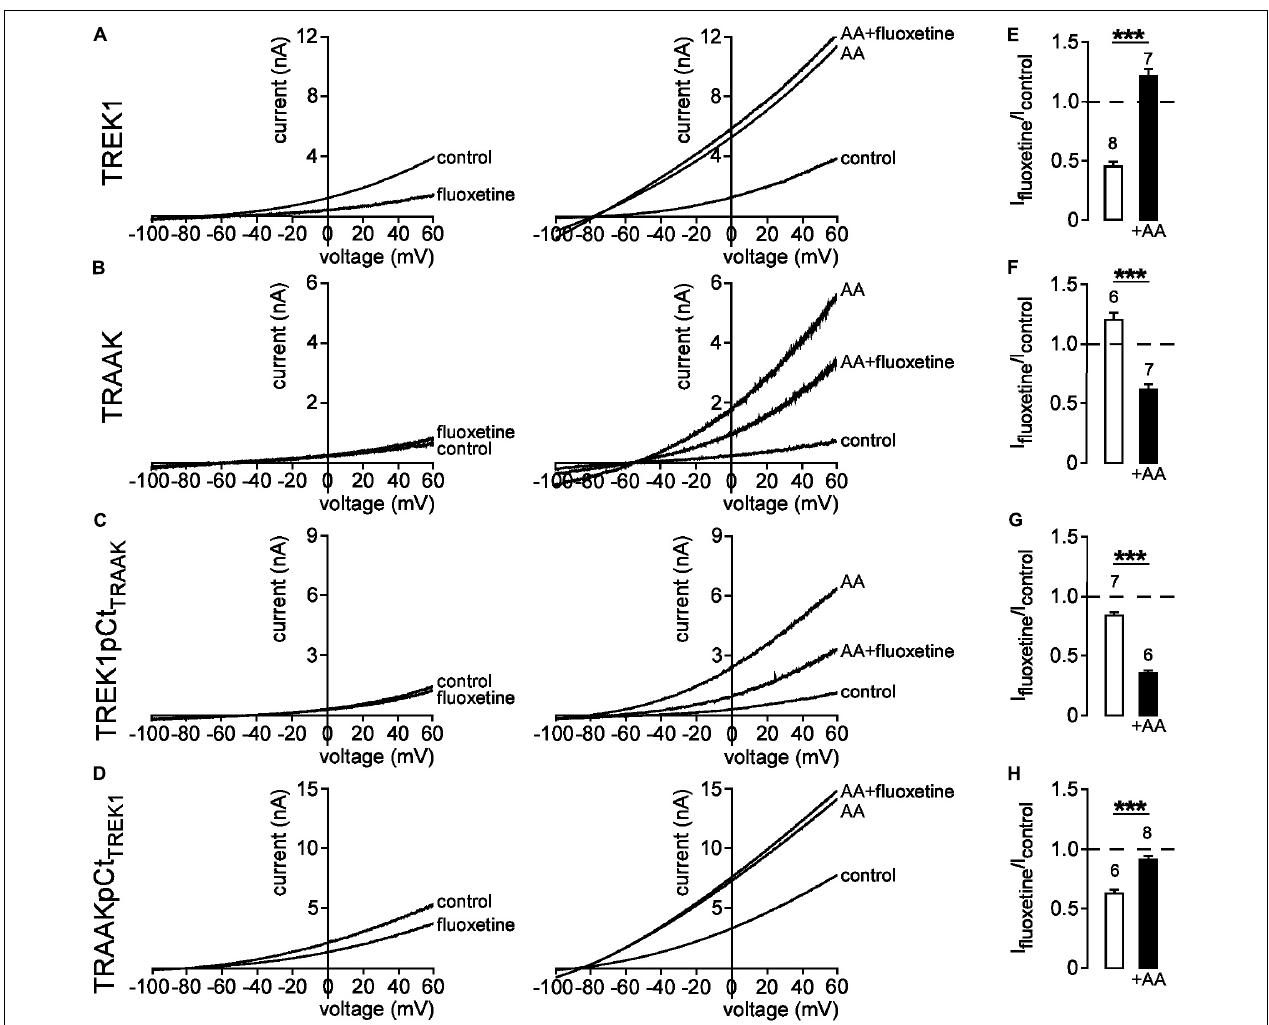
FIGURE 5 | State-dependent inhibitory effect of fluoxetine. (A–D) Representative patch-clamp recordings from HEK cells expressing wild-type or mutated channels in the presence or absence of 10 µ M fluoxetine on basal currents (left panel) and on currents stimulated by 10 µ M AA (right panel). ( E–H) Fraction of fluoxetine-sensitive current in the absence or presence of 10 µ M AA. Data are presented as mean ± SEM. ∗∗∗ p < 0.001, the number of cells is indicated (Student’s t